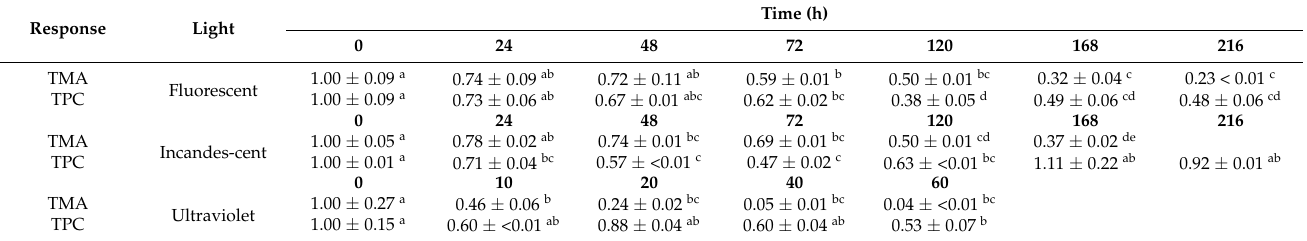
Table 4. Normalized values of TMA and TPC degradation by light exposure.